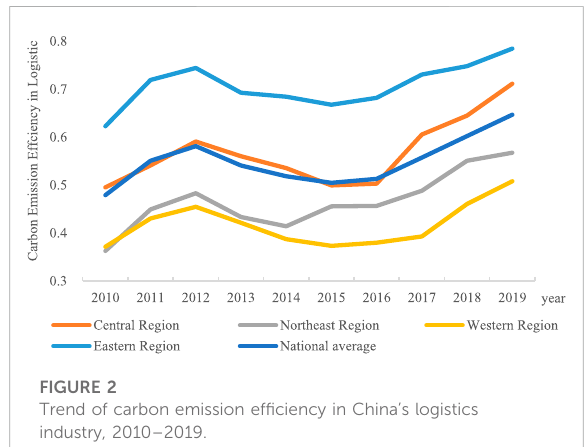
FIGURE 2 Trend of carbon emission ef fi ciency in China ’ s logistics industry, 2010 –